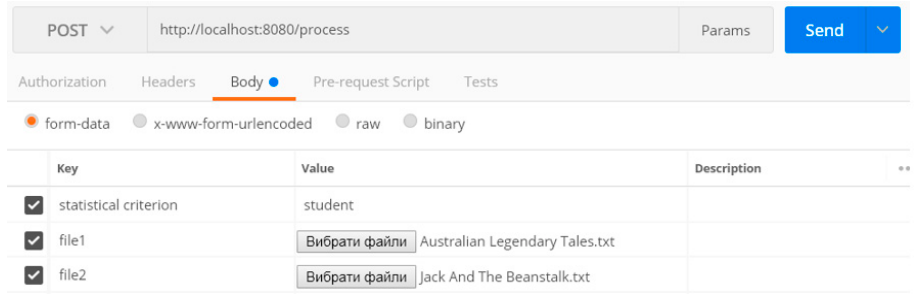
Figure 3. An example of the main menu of the program.